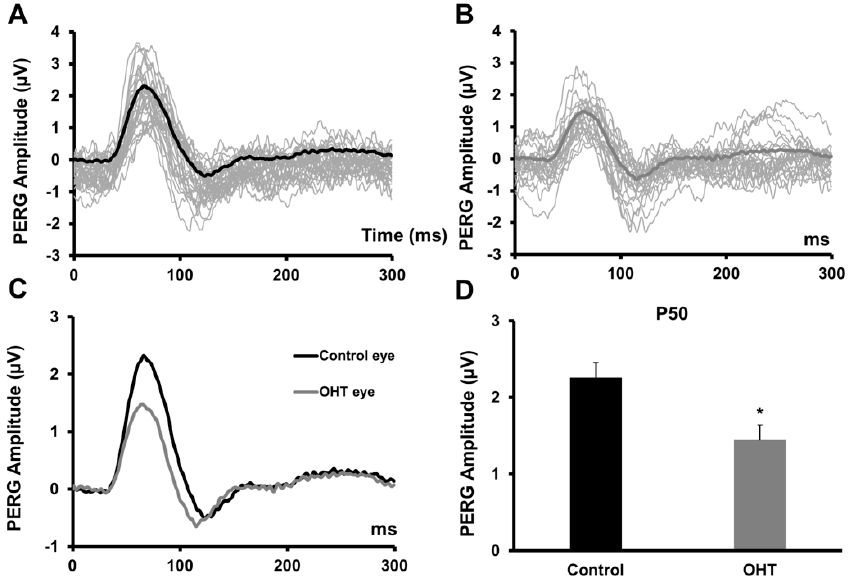
Figure 3. Effect of chronic IOP elevation on the retinal ganglion cells (RGCs) function. Pattern electroretinogram (PERG) P50 amplitude responses were significantly reduced in all hypertensive eyes. ( A , B ) Representative individual examples of PERG recordings of control (A) and ocular hypertension (OHT) ( B ) eyes. Grey traces represent the individual waveforms and the superimposed black trace represents the average PERG responses. ( C ) Average PERG waveform responses, showing the difference between the hypertensive (grey) and untreated fellow control eyes (black). The elevation of IOP caused a remarkable average reduction (36%) in retinal responsiveness to the stimulating pattern. ( D ) Bar graphs showing the PERG P50 amplitude results. A significant difference in the P50 amplitude was observed between hypertensive eyes and control fellow eyes ( p <